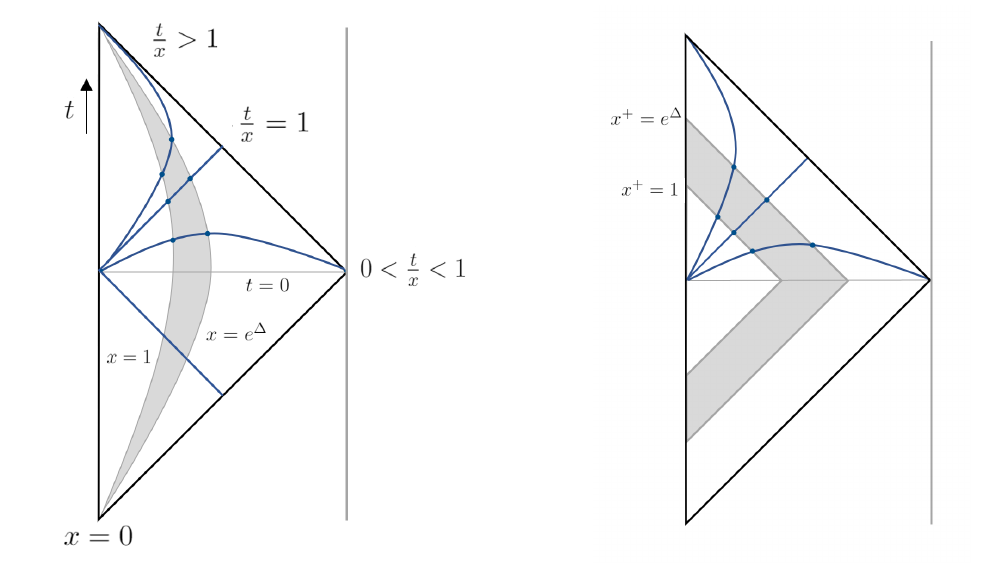
Figure 2. Different choices for the fundamental region of the Misner-AdS 2 spacetime (shaded in gray) when embedded in the Poincaré-AdS 2 half-diamond, (2.8) or (2.18). Blue dots indicate identified points, compactifying the gray strip into a cylinder. The identifications are along a light ray at the chronological horizon t/x = 1 , along timelike curves in the upper wedge t/x > 1 , and along spacelike slices in t/x < 1 . Left : the fundamental region is given in terms of ( t, x ) coordinates, as in (2.13). Right : the fundamental region is defined through x ± coordinates, as in